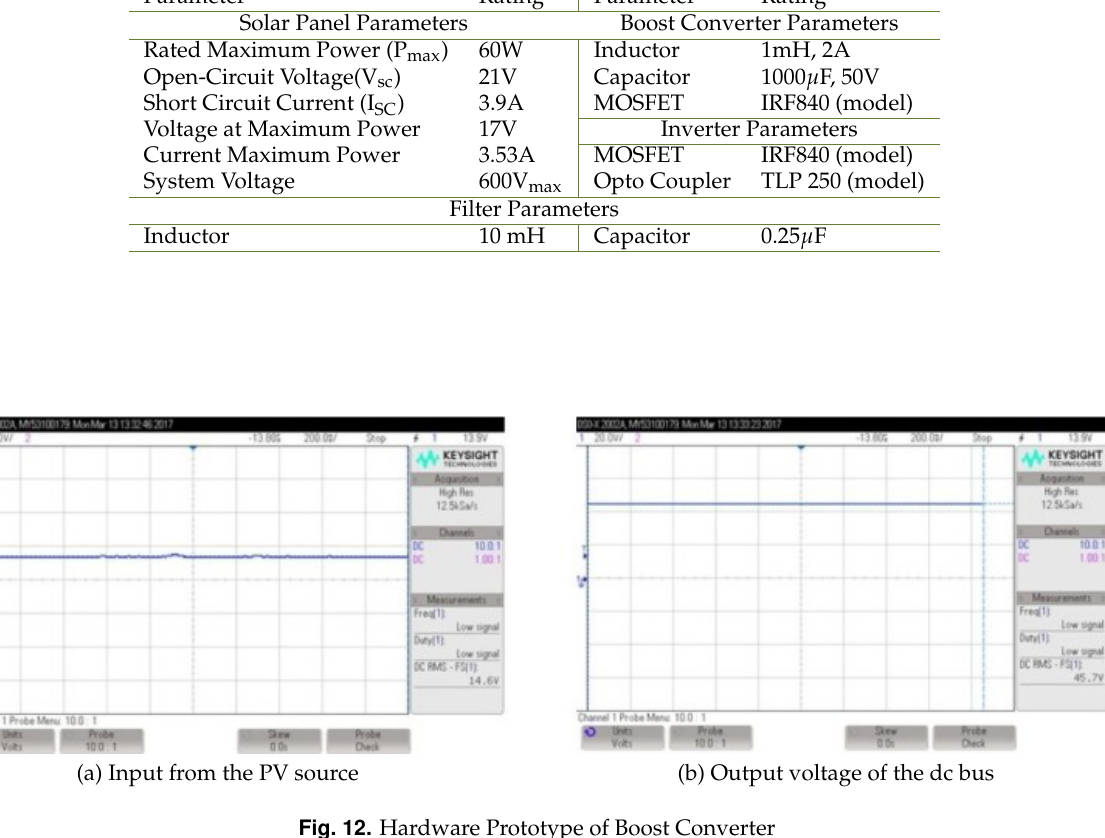
Fig. 12. Hardware Prototype of Boost Converter